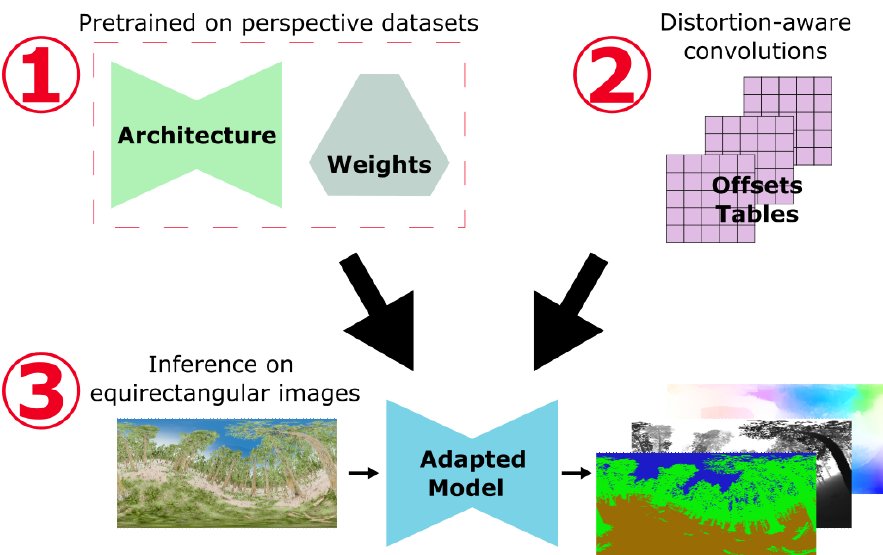
Figure 2. General adaptation process: 1. The architecture and weights come directly from pretraining on perspective datasets. 2. The convolution layers are modified using a precomputed shift table that takes into account equirectangular distortions. 3. Finally, we directly use spherical images as input in the adapted model to predict the modalities for which the network was